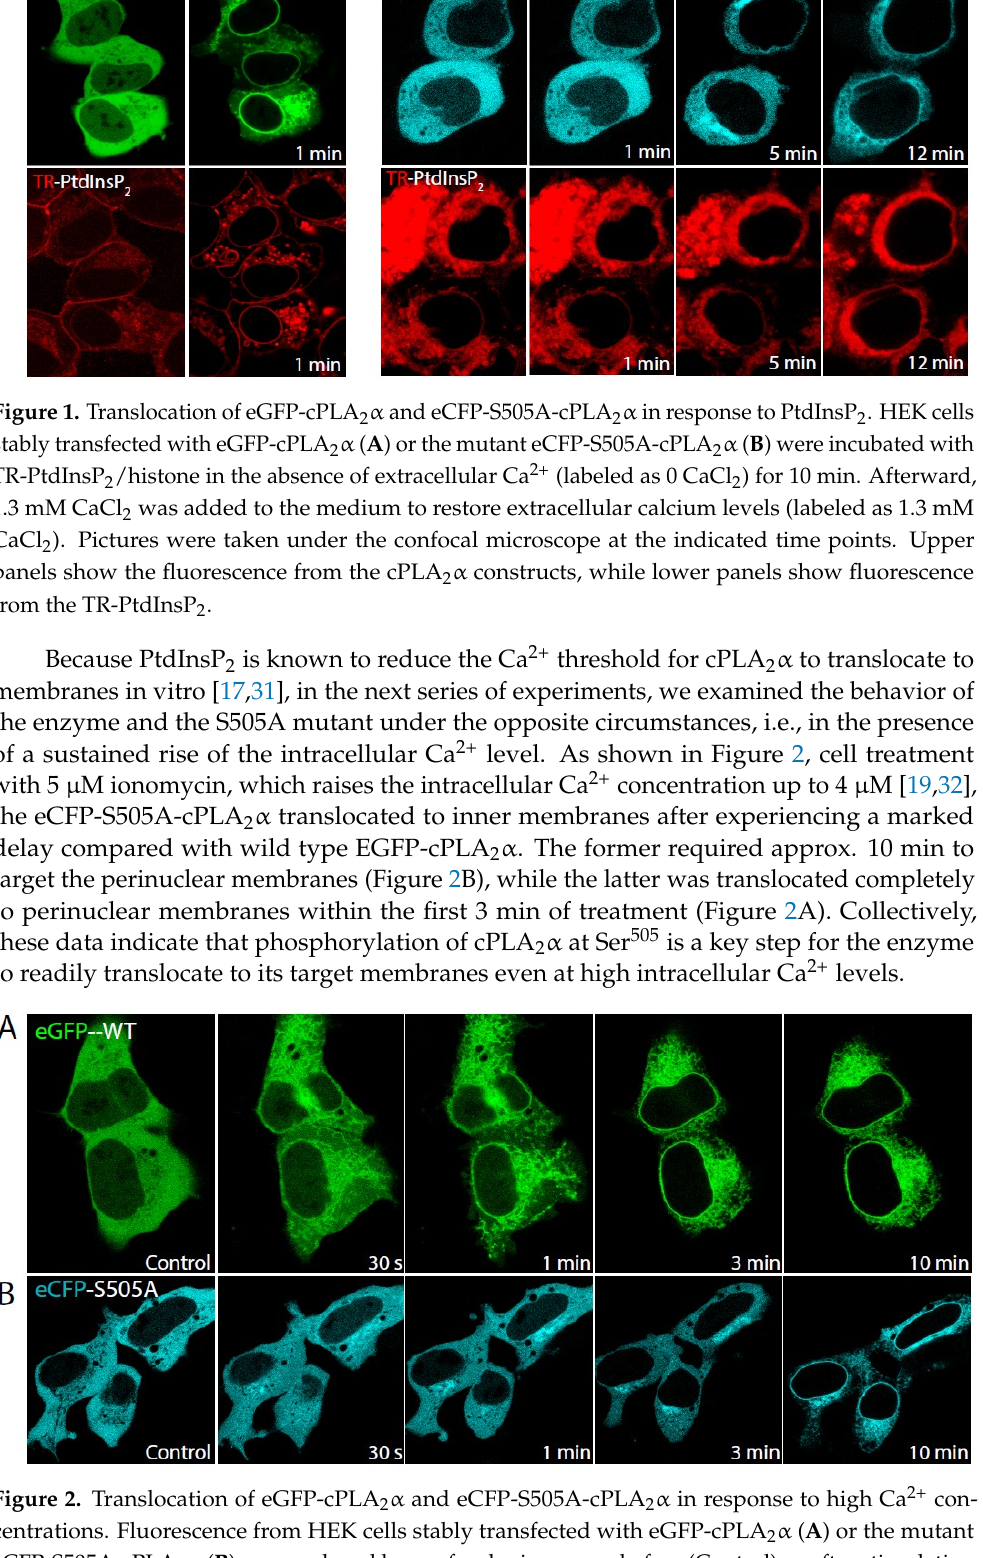
Figure 2. Translocation of eGFP-cPLA 2 α and eCFP-S505A-cPLA 2 α in response to high Ca 2+ con- centrations. Fluorescence from HEK cells stably transfected with eGFP-cPLA 2 α ( A ) or the mutant eCFP-S505A-cPLA 2 α ( B ) was analyzed by confocal microscopy before (Control) or after stimulation with 5 µ M ionomycin for the indicated periods of